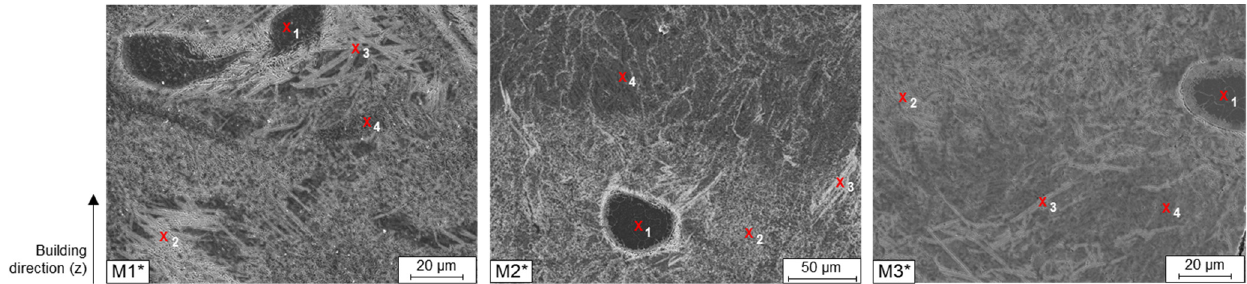
Figure 5. SEM microstructure of ( a ) M1*, ( b ) M2* and ( c ) M3*.